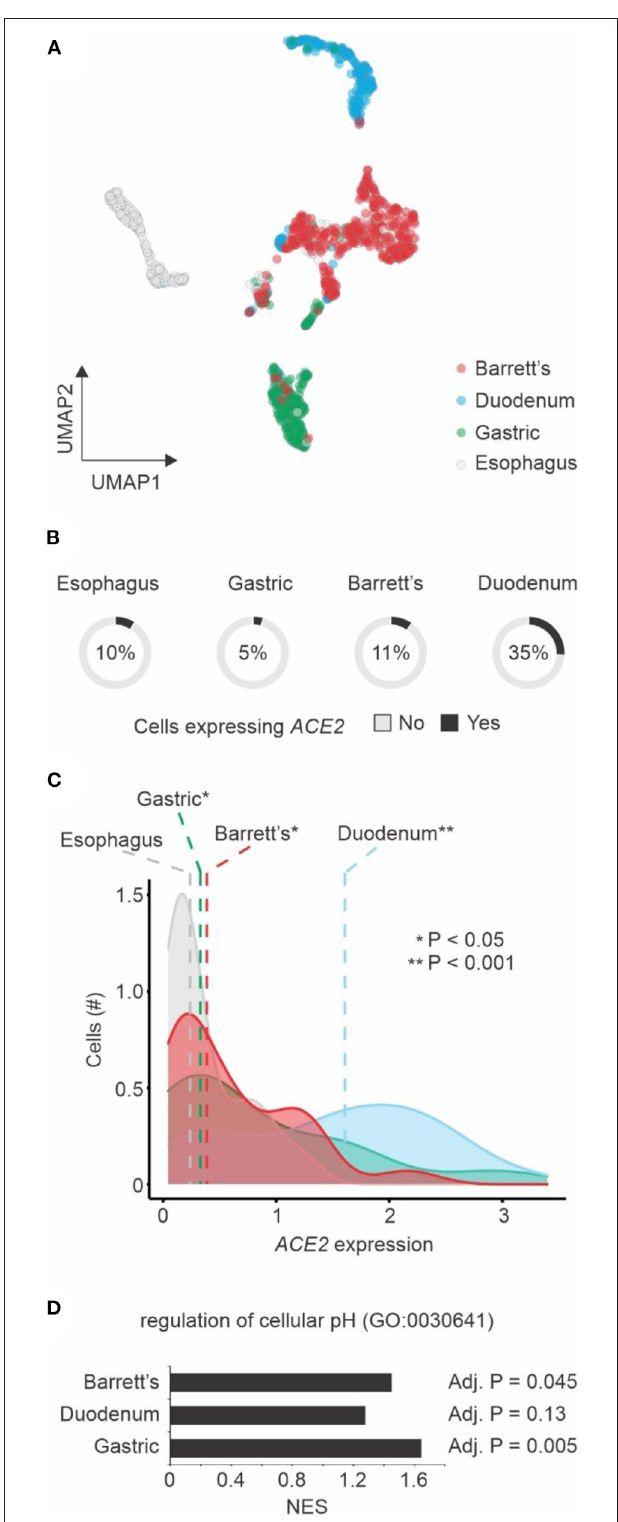
FIGURE 2 | Single cell transcriptomics of Barrett’s esophagus. (A) Dimension reduction of single cells using Uniform Manifold Approximation and Projection (UMAP). Cells from four patients with Barrett’s esophagus ( n = 1,168) are